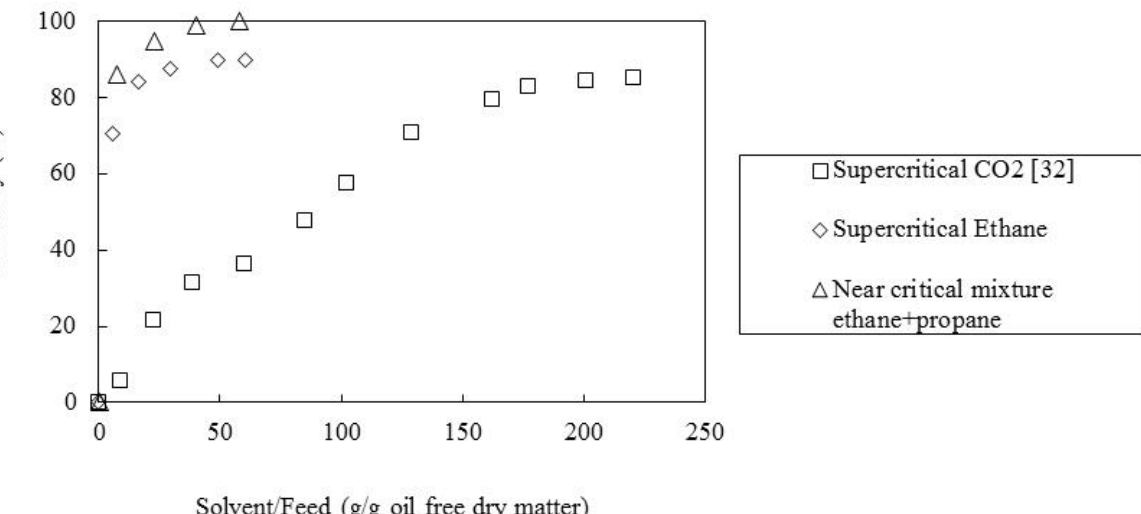
Figure 2. Recovery of all- E -lycopene from sample M2 as a function of solvent amount, at 60 °C, 300 bar, matrix particle size of 0.36 mm and solvent superficial velocity of 1.44 cm/min, for the solvents tested.